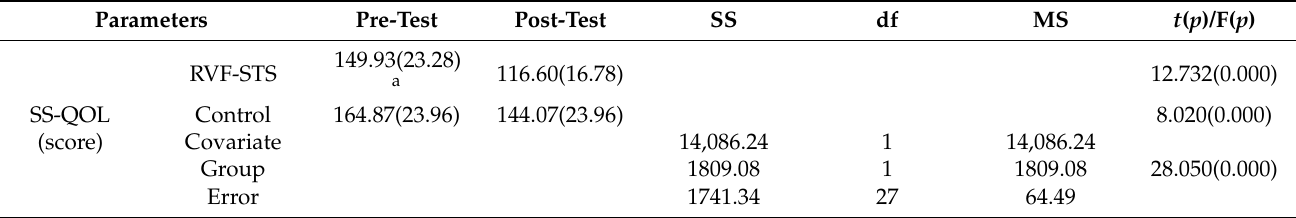
Table 6. Comparison of quality of life ( N =